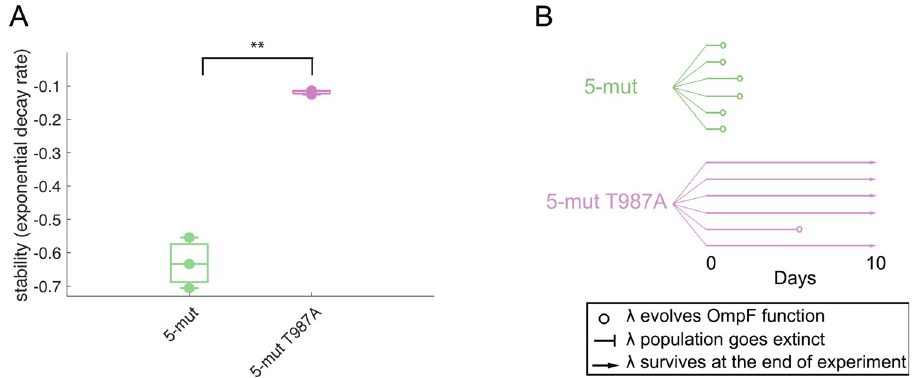
Fig 7. Stability and evolvability of 5-mut and 5-mut T987A stable variant. A: In a background that is further away from evolving OmpF+ (two mutations reverted compared to one mutation in 6-mut), the T987A mutation is still stabilizing. B : In the 5-mut background, T987A reduces evolvability to an even greater extent. Two sample t-test for unequal variance, N = 3 per genotype, �� : P = 0.0069.